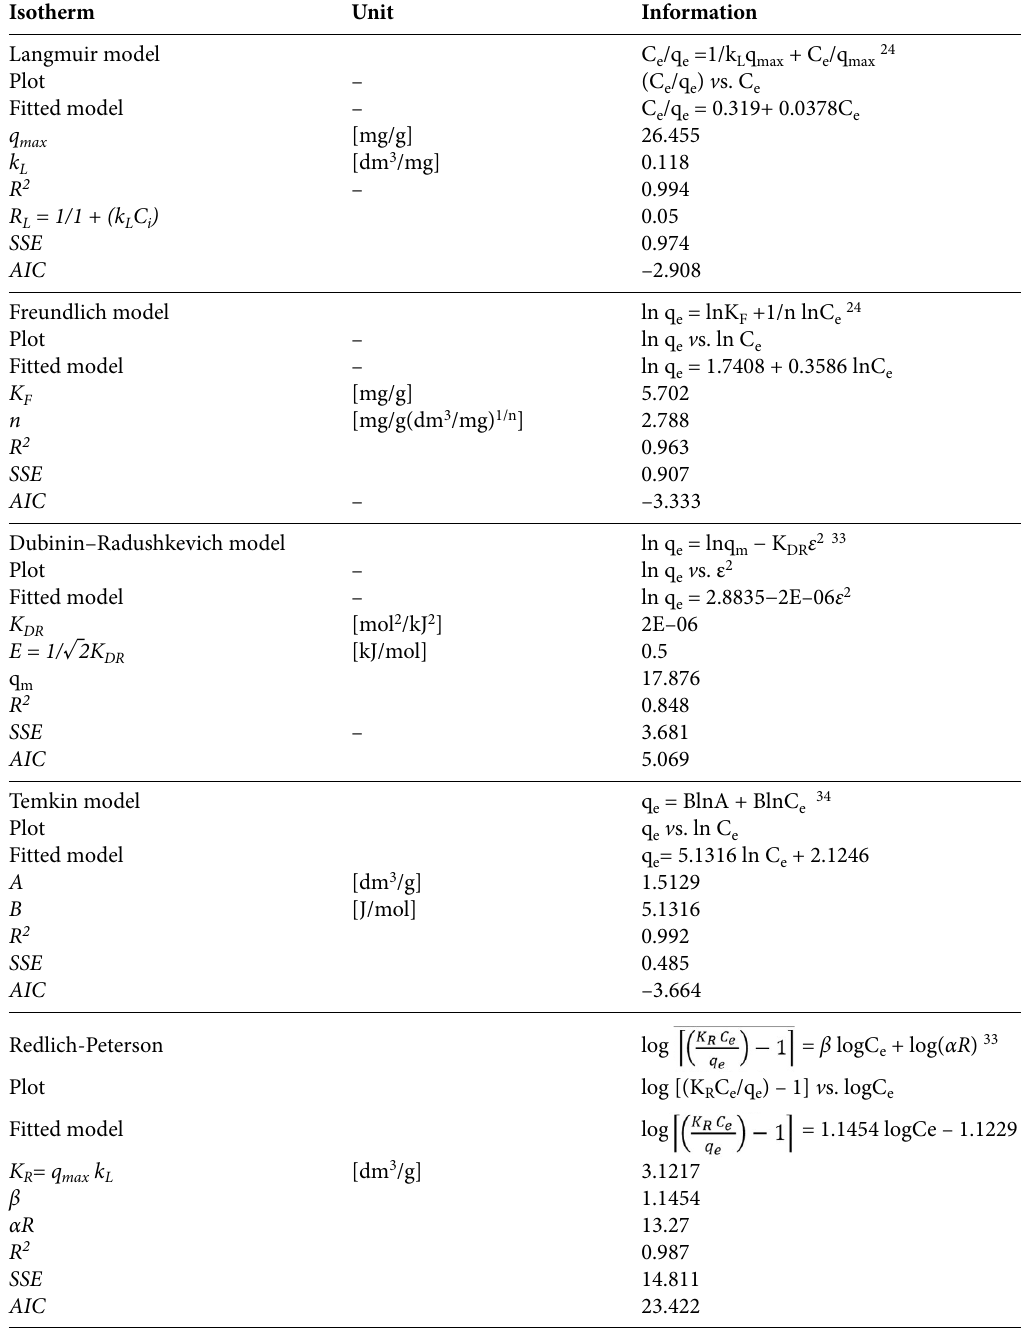
Table 5. Equilibrium modeling for the adsorption of AV 17 by the AAPS. Isotherm Unit